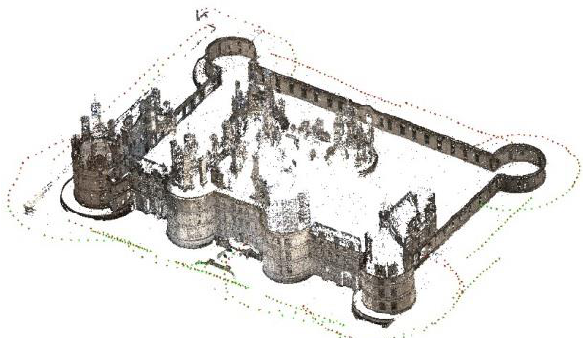
Figure 6: View of the tie points and the position of the 35 mm cameras